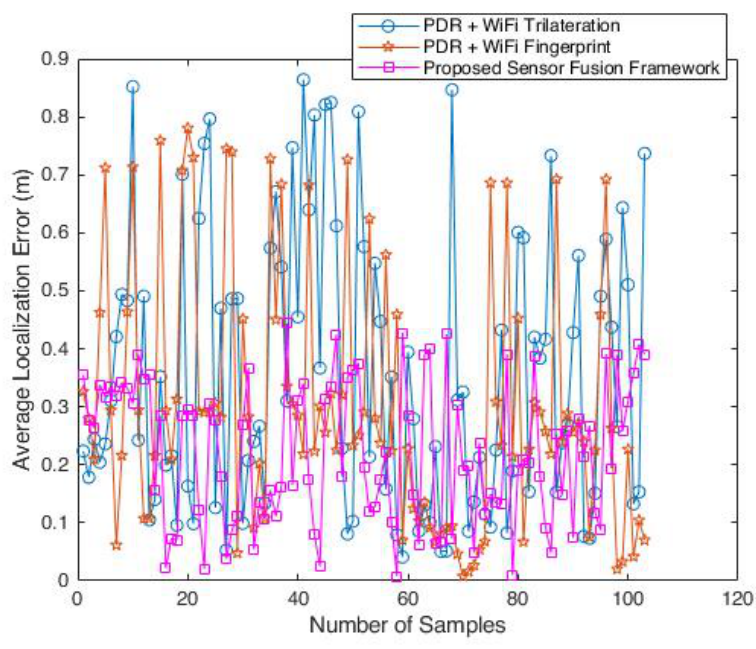
Figure 10. Average localization error from linear